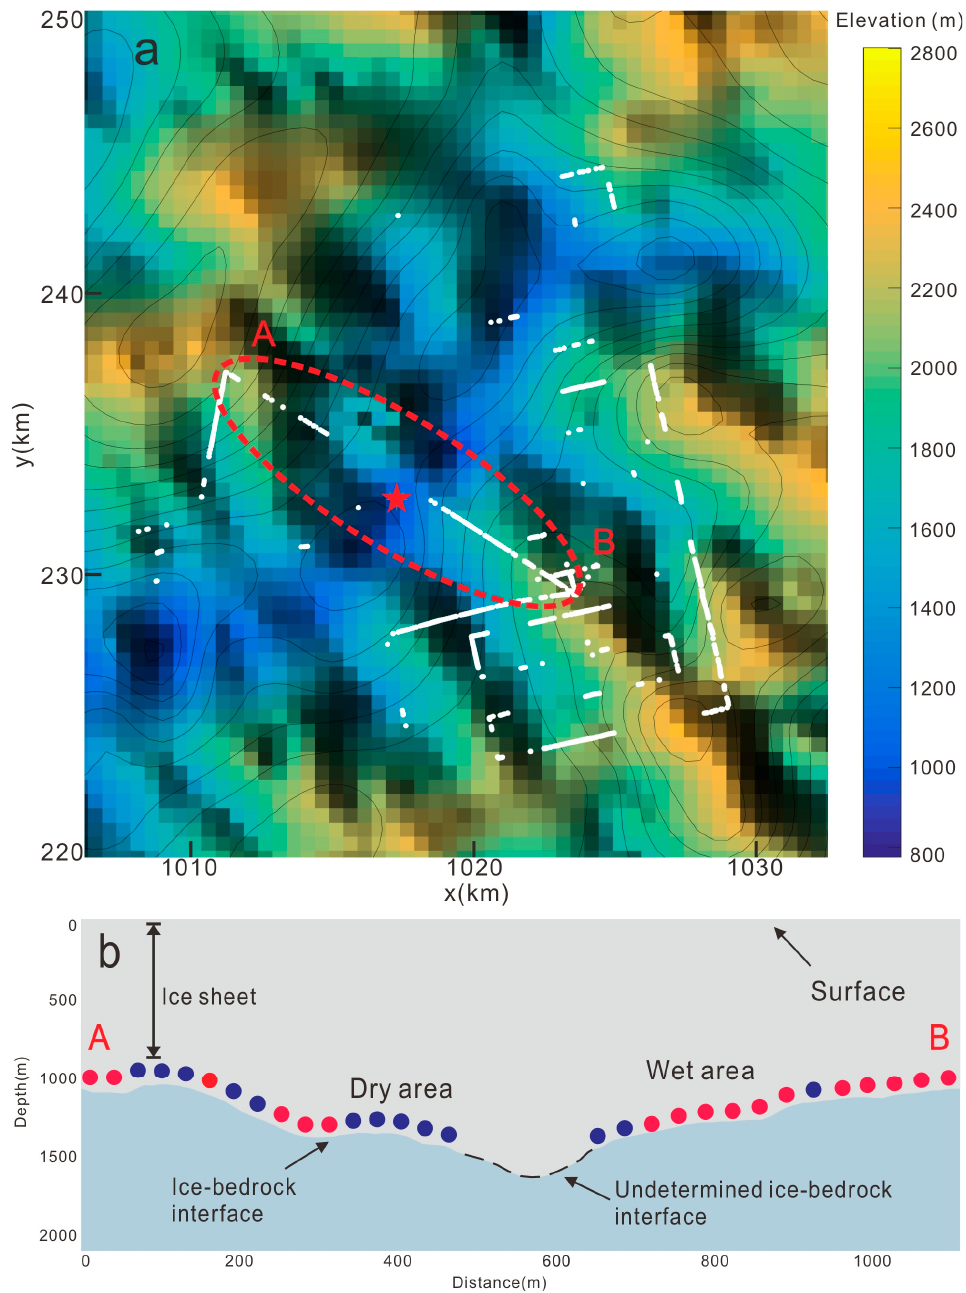
Figure 6. ( a ). Wet map on a color bedrock elevation map (contour spacing 100 m) around drilling site at Kunlun Station in the Dome A region; white points are wet points, asterisk is the Kunlun Station. ( b ). Dry–wet schematic diagram of the marked area in ( a ) (red points for wet ice–bedrock interface s; blue points for dry ice–bedrock